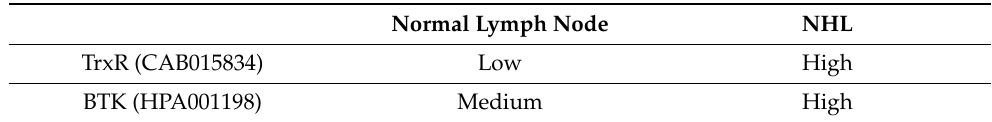
Table 2. Expression levels of the Trx system and BCR signalling pathway-related proteins in NHL and healthy samples retrieved from the Human Protein Atlas.